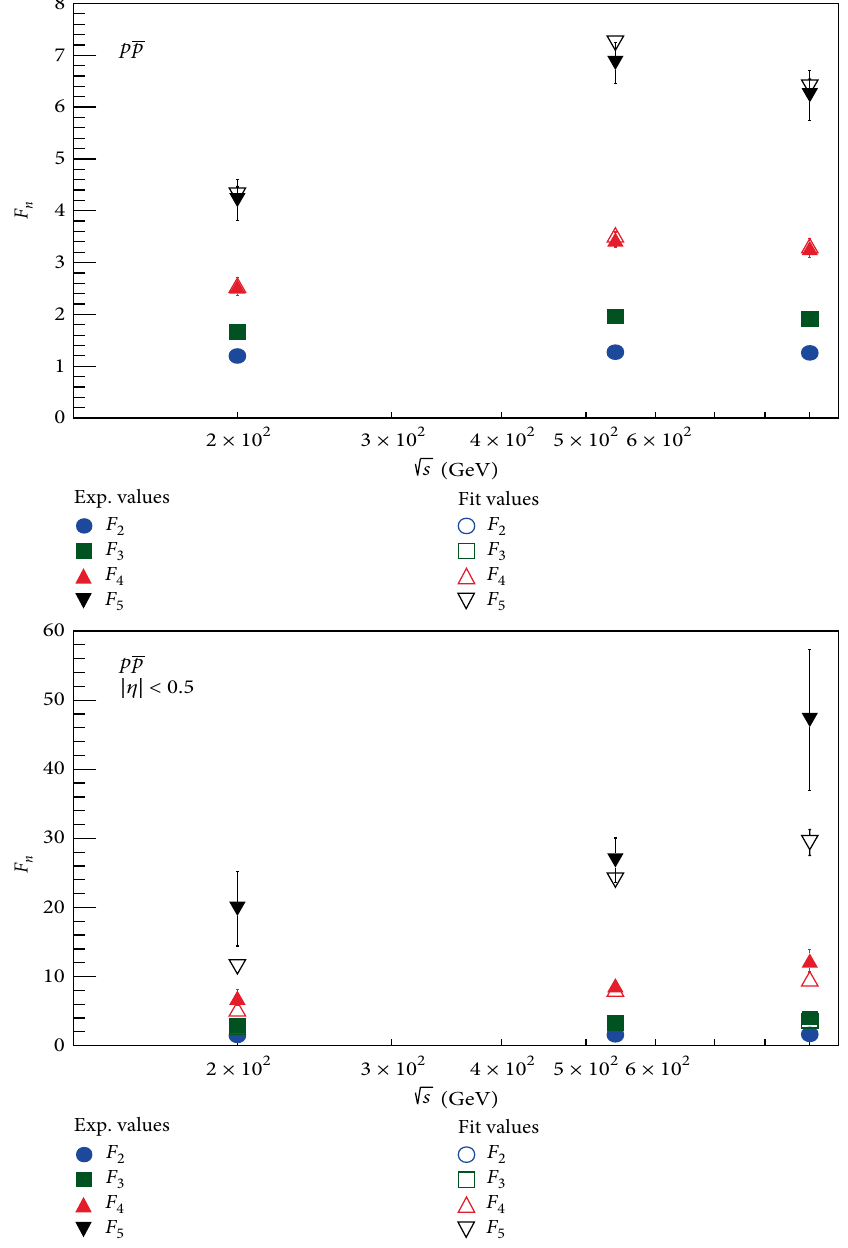
Figure 9: Normalized factorial moments F at different energies, in full phase space and pseudo-rapidity bin, | η | <